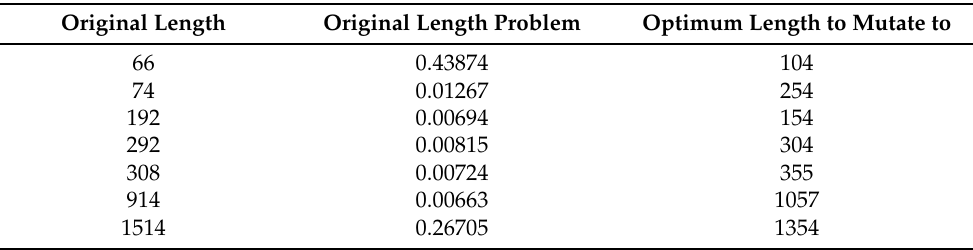
Table 8. Sample of length mapping of WhatsApp app, using OPriv.